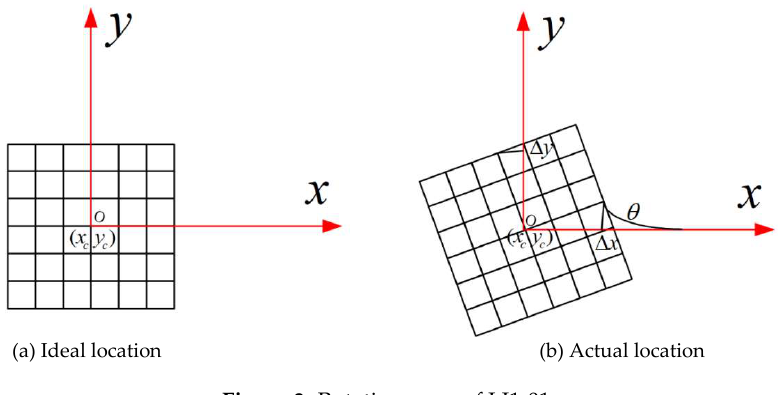
Figure 3. Rotation error of LJ1-01.